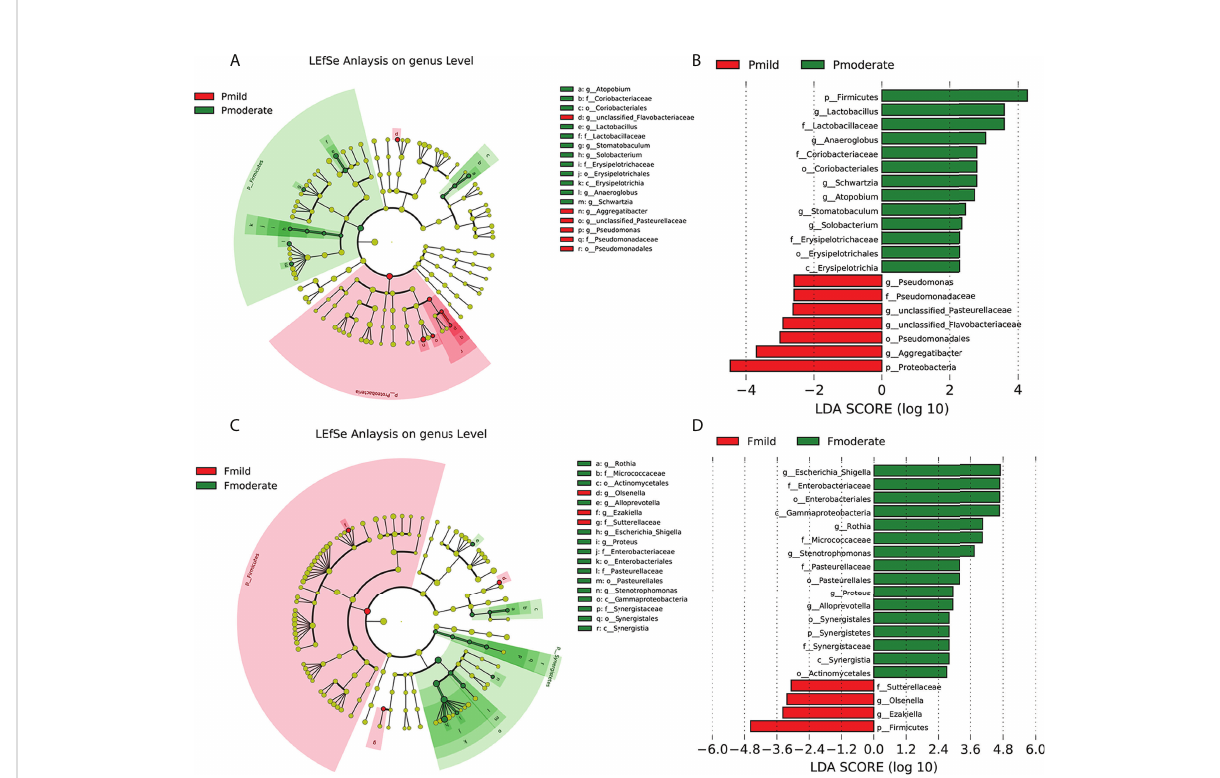
FIGURE 5 Key taxonomic differences of subgingival plaque and fecal microbiota in patients with mild and moderate AD. Cladogram using LEfSe method indicatingthe phylogenetic distributionof the subgingival (A, B) and fecal (C, D) microbiotas. Each circle ’ s diameter is proportional to the taxon ’ s abundance. Asis shown in the histogram ofthe LDA scores for differentially abundant taxa, positive LDA scores indicate the enrichment oftaxa in moderate ADgroup (green) relative to the controlgroup (red),and negative LDAscores indicate the depletionof taxa. LDAscores (log10) > 2 and p < 0.05; Pcn, subgingival plaque ofnormal cognitioncontrols; Fcn, feces of normal cognition controls; Pmild, subgingival plaque of mild AD; Fmild, feces of mild AD; Pmoderate, subgingival plaque ofmoderate AD; Fmoderate,feces ofmoderate AD; LEfSe, linear discriminant analysis (LDA)